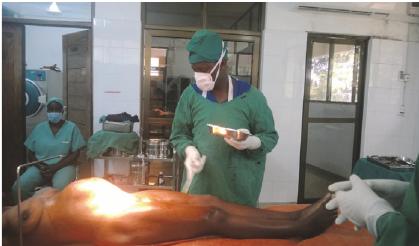
Figure 2: Intraoperative finding of giant haematometra and huge distended bilateral haemosalpinx.